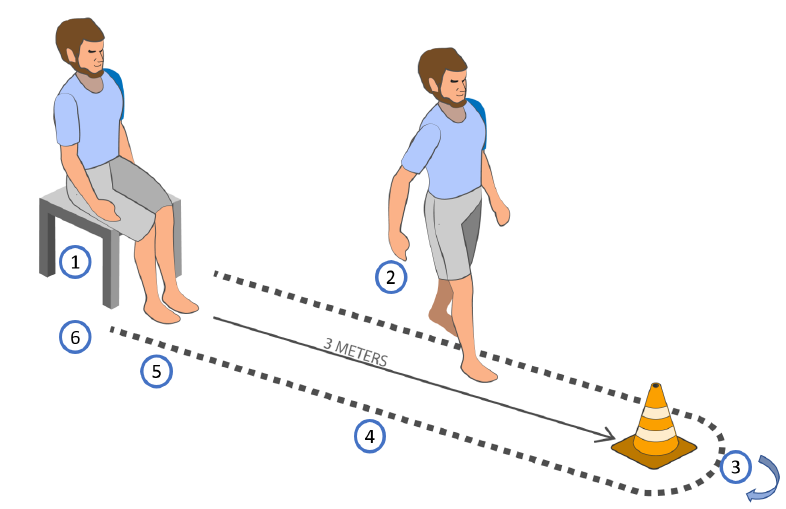
Figure 1. Activities performed in the 3-m TU & Go test. 1 = standing, 2 = first walk, 3 = 3-m turning, 4 = second walk, 5 = pre-sitting turning, and 6 =